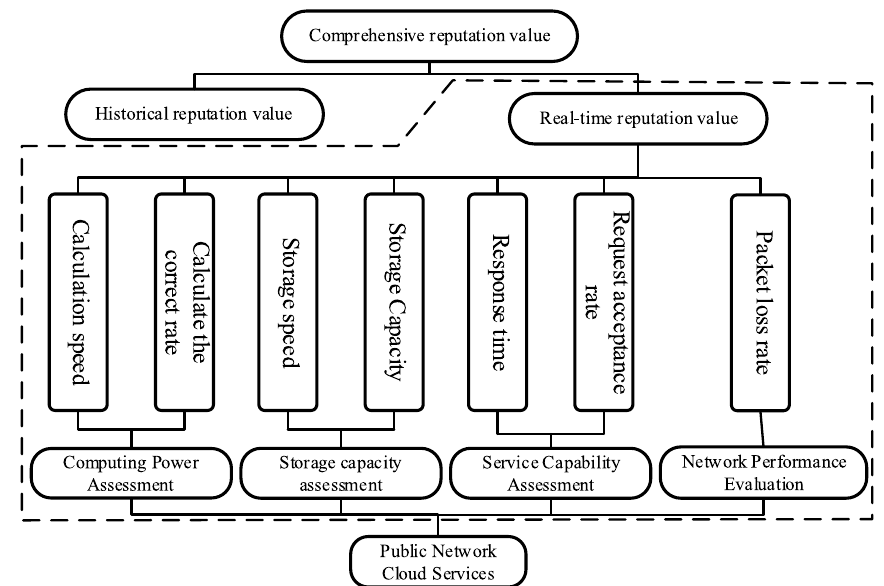
Fig. 7 Public network cloud service reputation assessment